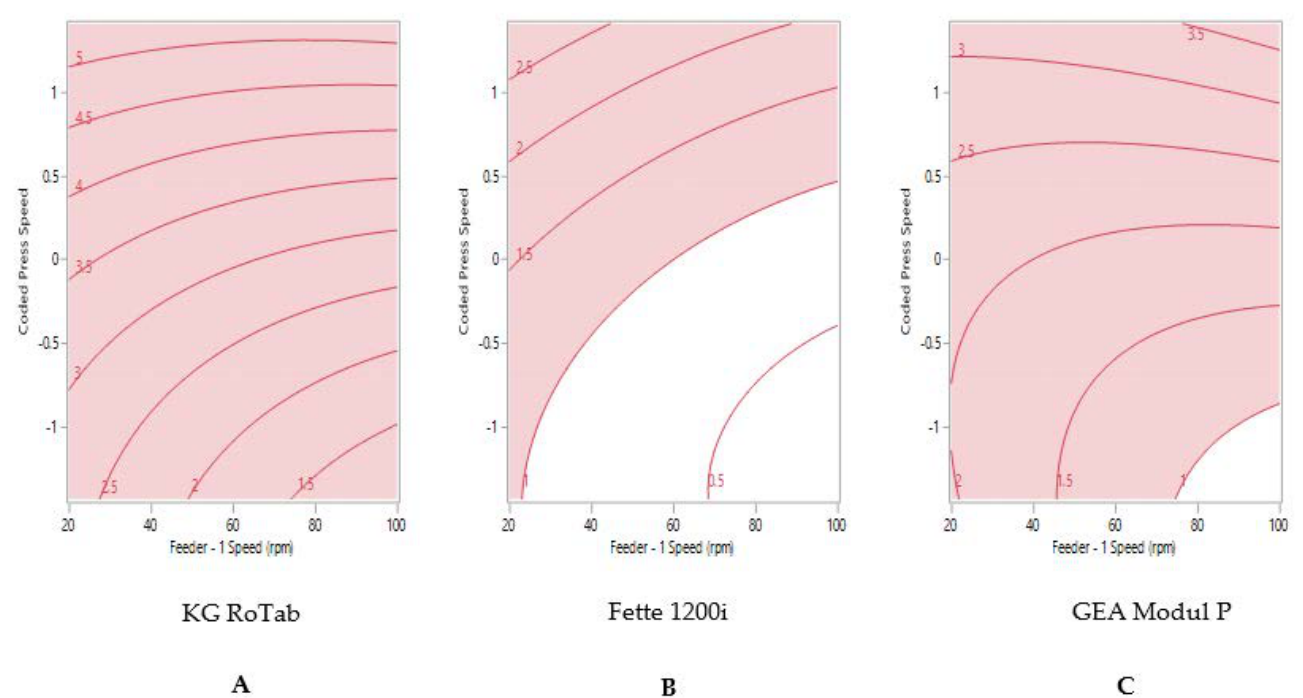
Figure 4. Two-dimensional contour profile showing optimum tablet press speed and feeder speed settings (uncoloured) for formulation 3 “passable flow” to achieve tablet weight variability ≤ 1% RSD on ( A ) KG RoTab, ( B ) Fette 1200i and ( C ) Modul P. Coded press speeds refer to standardized press speed for each tablet press by subtracting the mean press speed from the actual press speed and dividing by the standard deviation. Refer to supplementary information (Table S4) for the actual press speeds. Table 5. Permeability values for validation formulations, validation process settings, process model, actual tablet weight variability (%RSD) for validation formulations and predicted tablet weight variability (%RSD) values calculated by the process model, benchmarking validation formulations to formulation-2 (fair